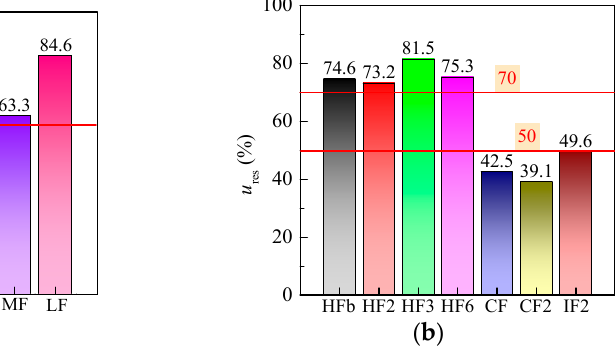
Figure 13. The strength ratios of different deformed steel fibers: ( a ) u de ; ( b ) u res .